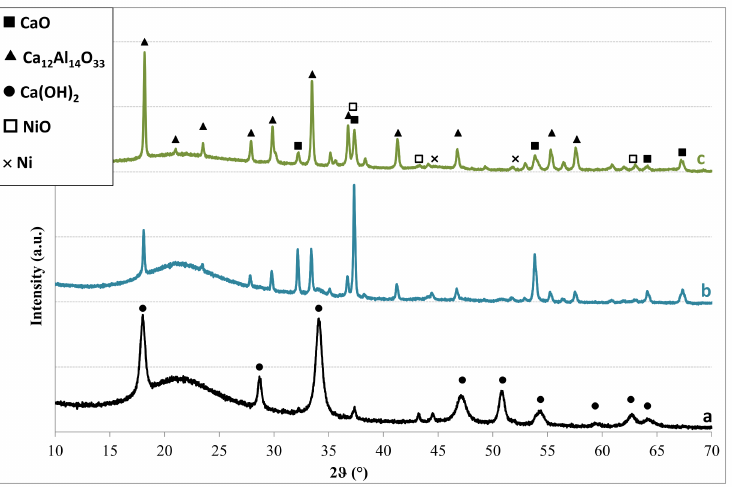
Figure 11. XRD analysis of bi-functional compounds after toluene reforming test: (a) C100Ni3, (b) C56Ni3, and (c)